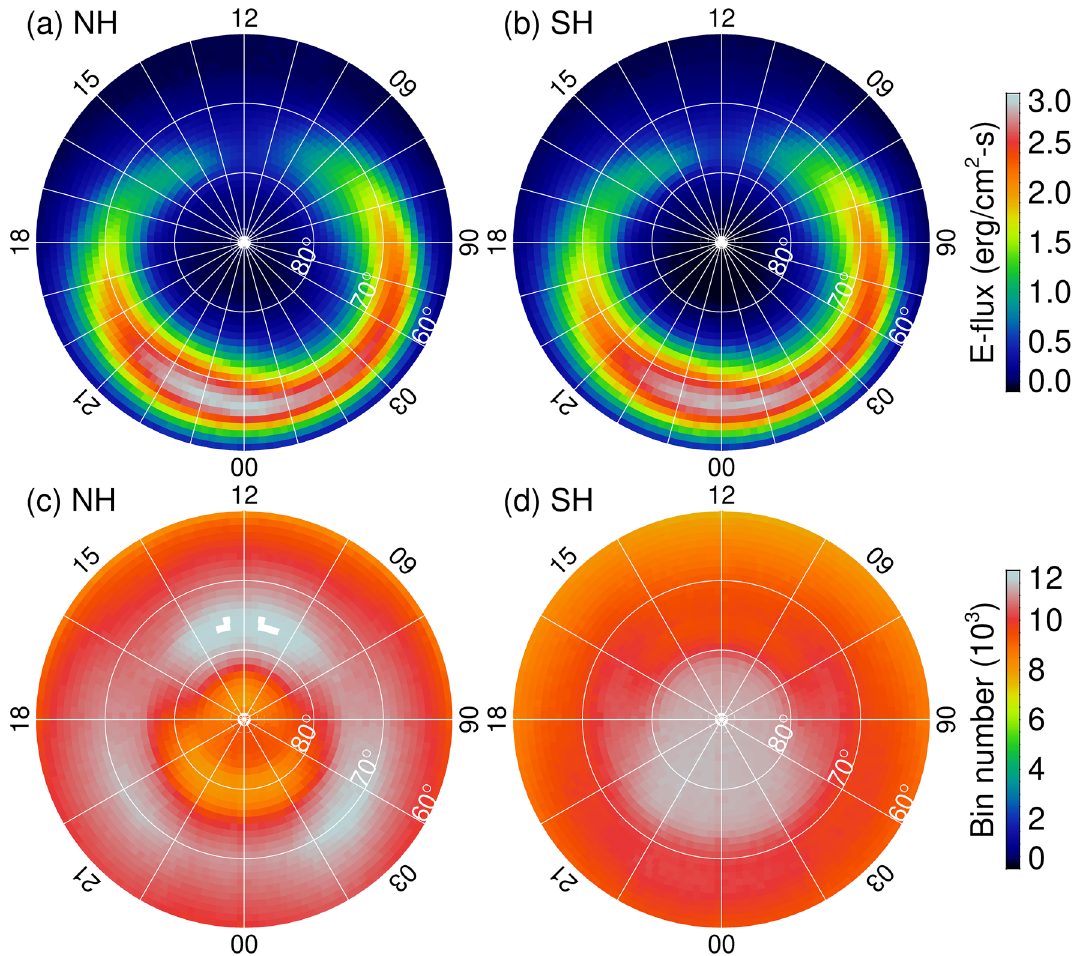
Figure 1. Longterm (2002–2007) averages of auroral energy flux inferred by TIMED/GUVI FUV auroral emission data for ( a ) Northern Hemisphere (NH) and ( b ) Southern Hemisphere (SH) in magnetic latitude (MLat)—magnetic local time (MLT) formats. The number of measurements per bin that are used to calculate the averaged energy is provided in ( c ) for NH and ( d ) for SH. There are 2,763 bins in total in each hemisphere. The figure is produced by the first author using the Interactive Data Language (IDL) software version 8.2.3. The ULR link for IDL is https ://www.harri sgeos patia